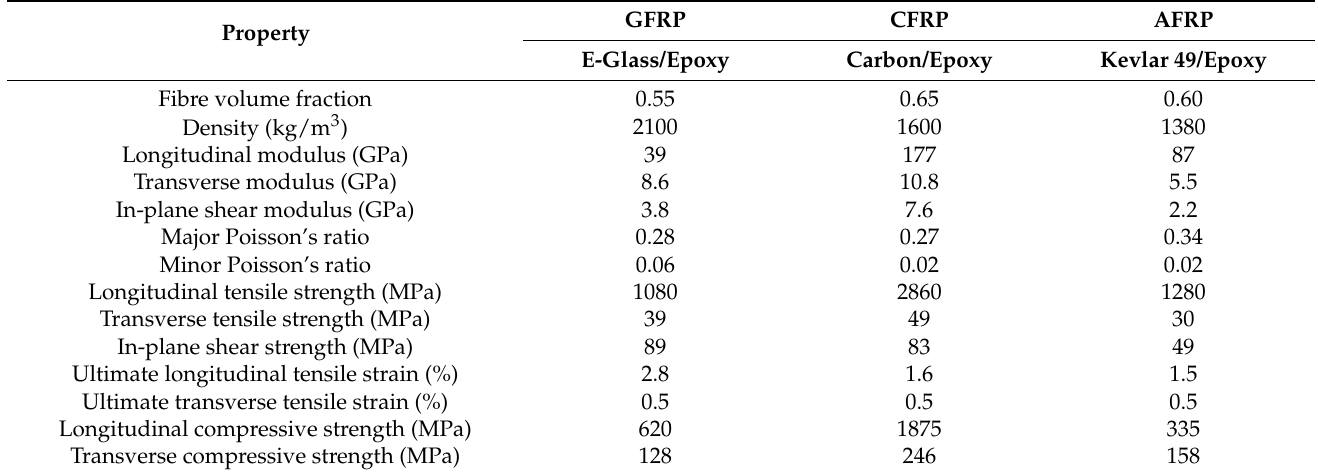
Table 4. Typical mechanical properties of GFRP, CFRP and AFRP reinforcing bars